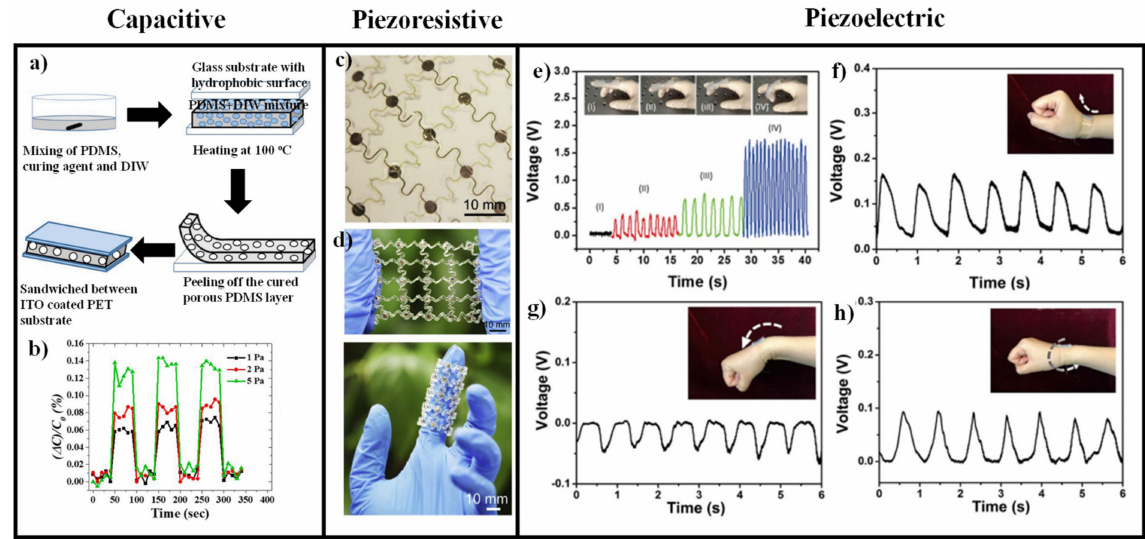
Figure 5. The fabrication process of PDMS-DIW: ( a ) Outline of the procedure to manufacture the sensing instrument with a porous dielectric layer (PDMS-DIW) [124], ( b ) sensing performance of the instrument in terms of capacitance change at 1–5 Pa pressure span [124]. ( c ) An optical image of the Au electrode made by MEMS [125], ( d ) stretchable sensing instrument adjusts to pressure detection under complex deformation settings such as stretching and bending [125]; Piezoelectric P sensing instrument used for detecting joint motion states ( e ) finger motion states [126], ( f ) change in produced voltage under upward bending wrist movement [126], ( g ) change in generated voltage under downward bending wrist movement [126], ( h ) change in generated voltage under torsion wrist movement